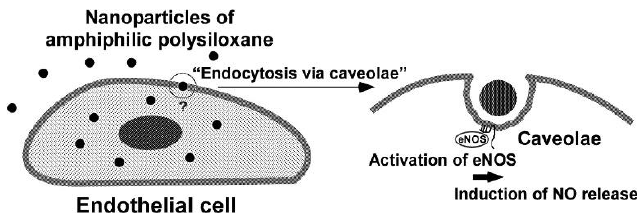
Figure 6. Scheme of nitric oxide release mechanisms by endocytosis via caveolae. Reprinted from [33], © 2002 with permission from ACS Publications.